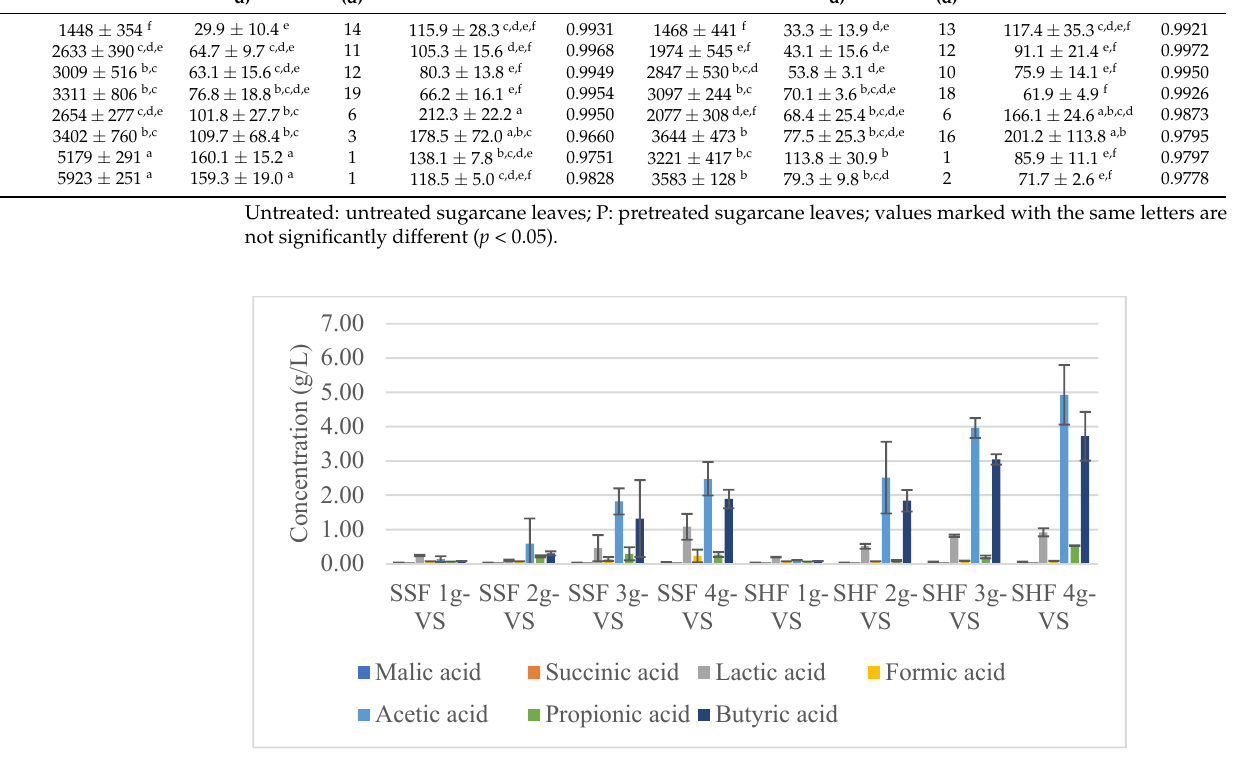
Table 7. Effects of substrate loading on enzymatic hydrolysis of untreated and DES pretreated sugarcane leaves by the cellulolytic consortium.